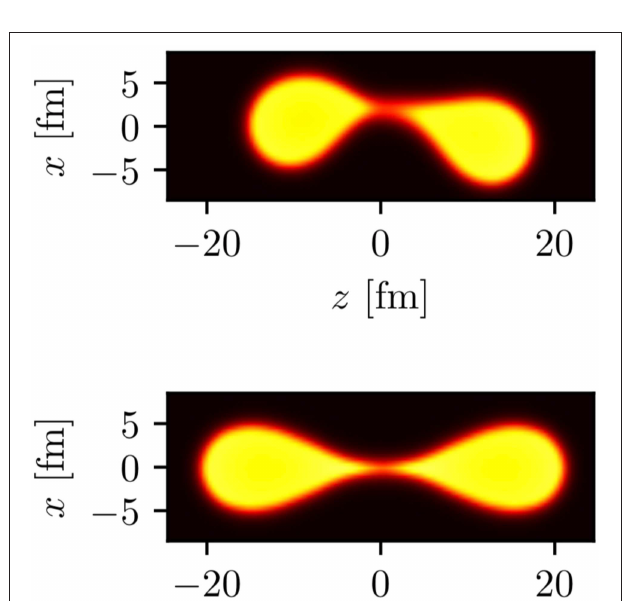
FIGURE 6 | We compare here the average neutron multiplicity FFs using a CGMF simulation [70], which assumes an E n dependence for the energy sharing extracted using the excitation energy sharing between the FFs in our calculation with NEDF SeaLL1, as a function of the equivalent incident neutron energy in 235 U(n,f) reaction along with available experimental data [ 71]. Note that in this figure the parametrization was based on 240 Pu calculations, while 236 U calculations are in progress.